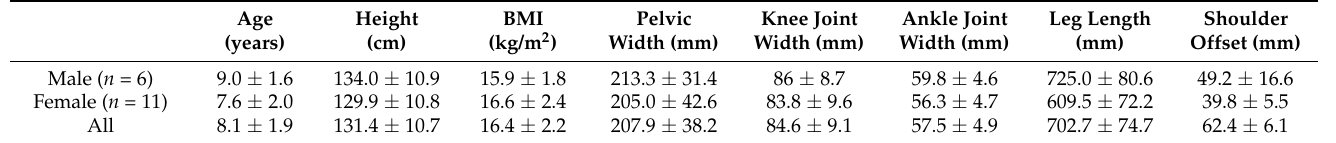
Table 1. Demographic and descriptive data of the participants, n =